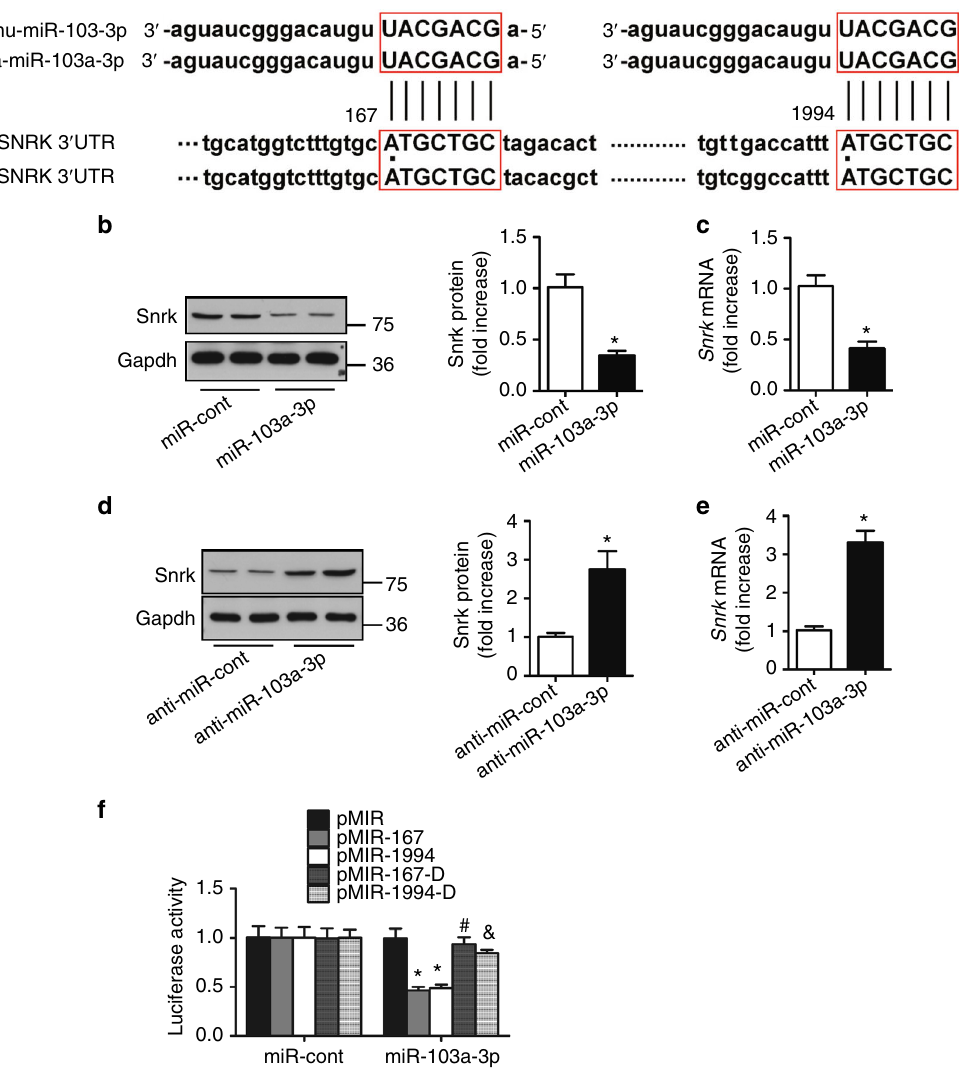
Fig. 4 SNRK is a target of miR-103a-3p. a Sequence analysis of human and mouse miR-103a-3p and SNRK mRNA 3 ′ UTR. Putative miR-103a-3p and SNRK mRNA 3 ′ UTR binding regions are highlighted with red boxes. b – e Primary GnECs were transfected with miR-103a-3p ( b , c ) or anti-miR-103a-3p ( d and e ) for 36 h. Snrk protein levels were assessed using Western blotting and densitometry ( b , d ), and Snrk mRNA abundance was measured using qRT-PCR ( c , e ). For all experiments, n = 6 per group; * p < 0.05 relative to miR-Control. f Luciferase activity assays were performed to assess whether the regulatory effect of miR-103a-3p requires the predicted binding sites in the SNRK mRNA 3 ′ UTR in HEK293 cells. pMIR167 and pMIR1994 harbored the 167 and 1994 putative binding sites, respectively (indicated in a ), whereas the respective binding sites were individually deleted in pMIR167 Δ and pMIR1994 Δ . n = 6 per group, * p < 0.05 relative to pMIR; # p < 0.05 relative to pMIR-167; & p < 0.05 relative to pMIR-1994. Statistical analysis was carried out with a Student ’ s two- tailed t -test. The corresponding source data are available in the Source Data fi